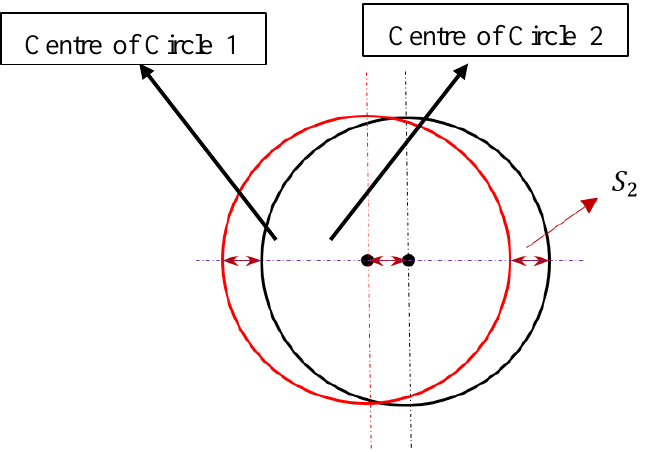
Figure 4. Schematic view from the top view for the in contact and not contact area including the additional circle.